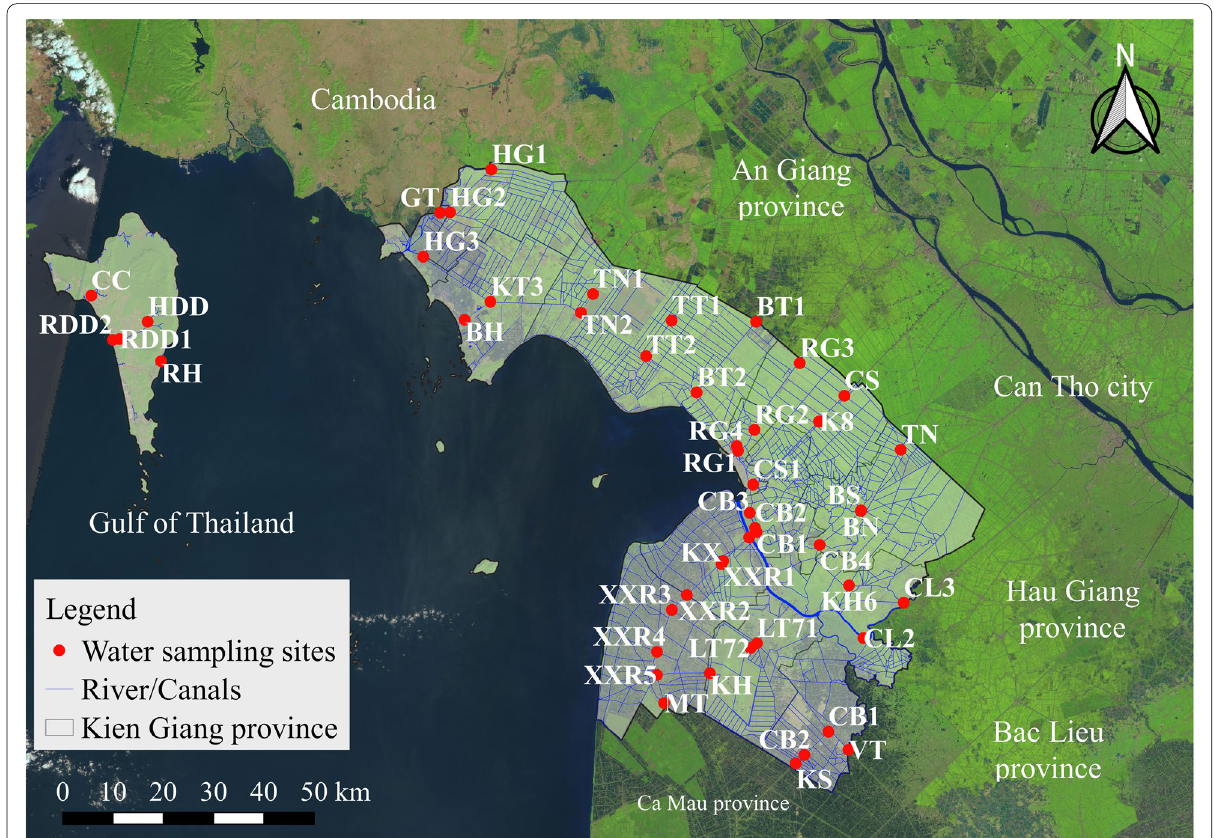
Fig. 1 Location map of surface water sample collection in Kien Giang province,